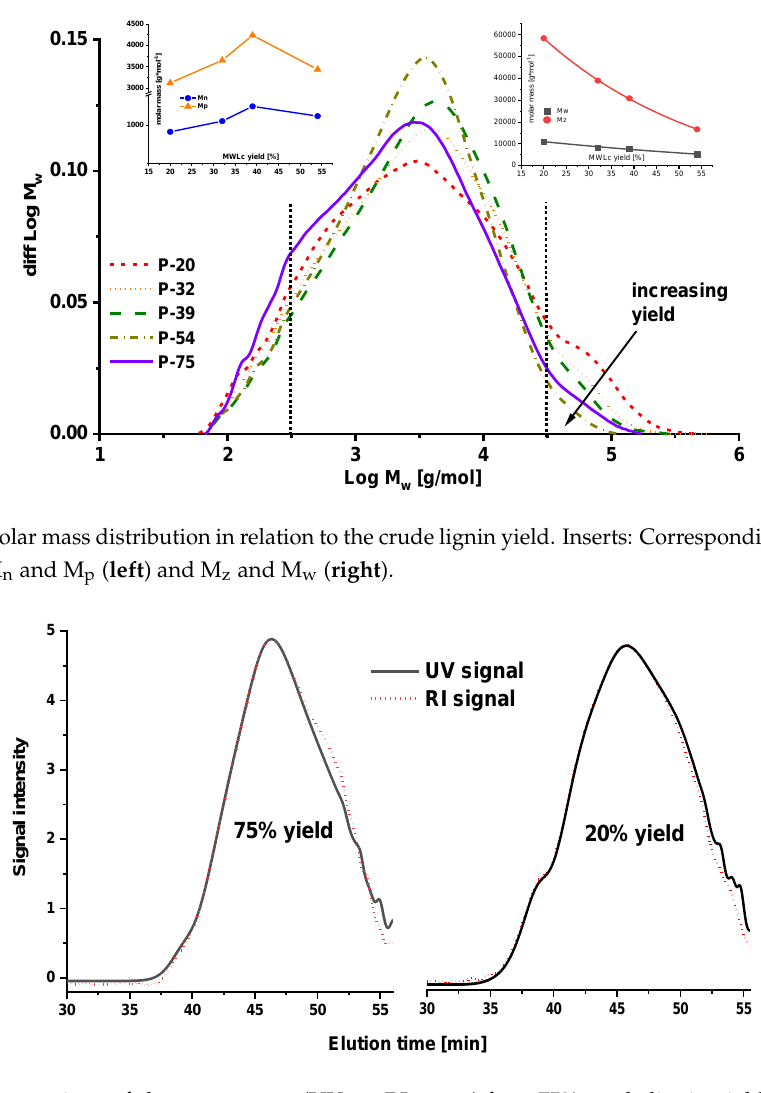
Figure 3. Comparison of chromatograms (UV vs. RI traces) for a 75% crude lignin yield ( left ) and a 20% crude lignin yield ( right ).